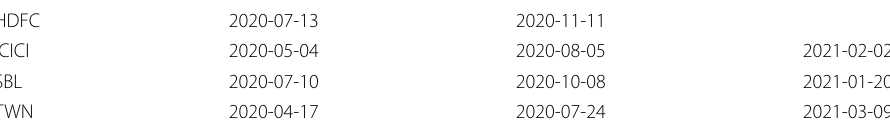
Table 8 Bai and Perron (2003) structure change test